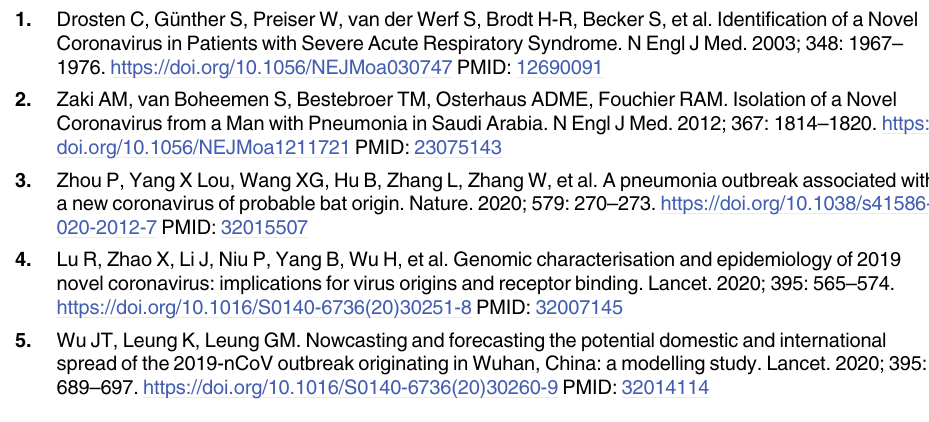
S1 Fig. Correlation analysis between interleukin (IL)-6 levels in plasma and its levels in bronchoalveolar lavage fluid (BALF). IL-6 levels at the same time point in plasma and BALF from patients with critically ill COVID-19 (n = 10) were measured with ELISA kit. Individual data are shown as closed